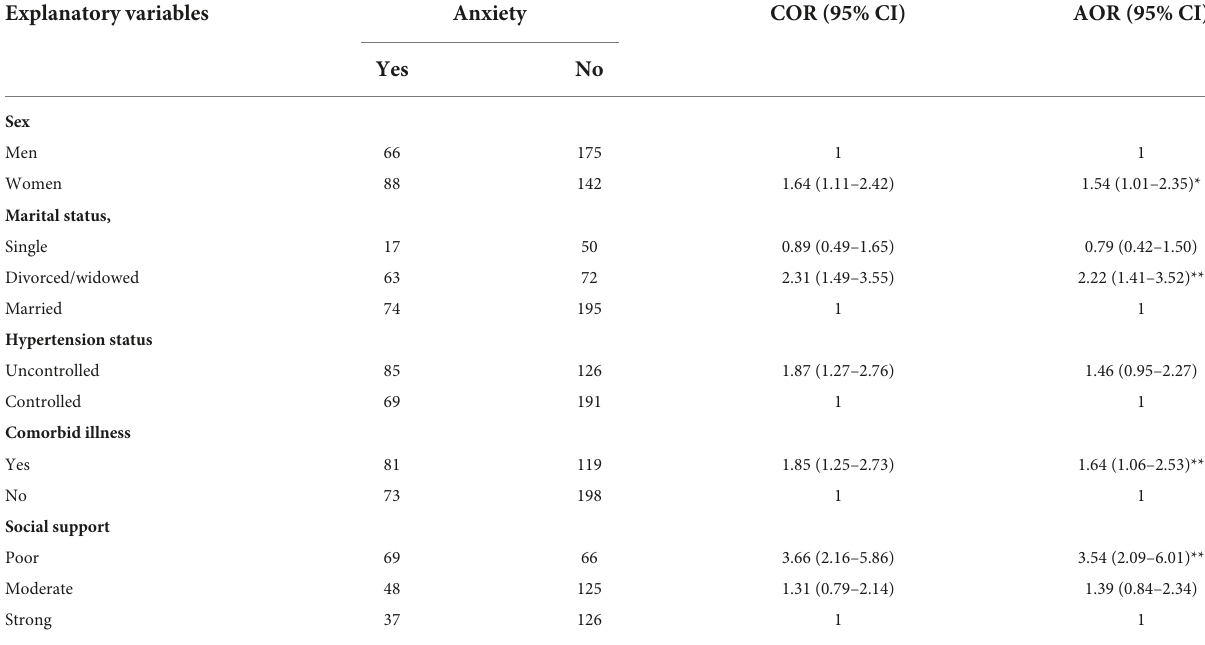
TABLE 4 Factors associated with anxiety symptoms in people with hypertension on follow-up in Eastern Ethiopia ( n = 471). Explanatory variables Anxiety COR (95%